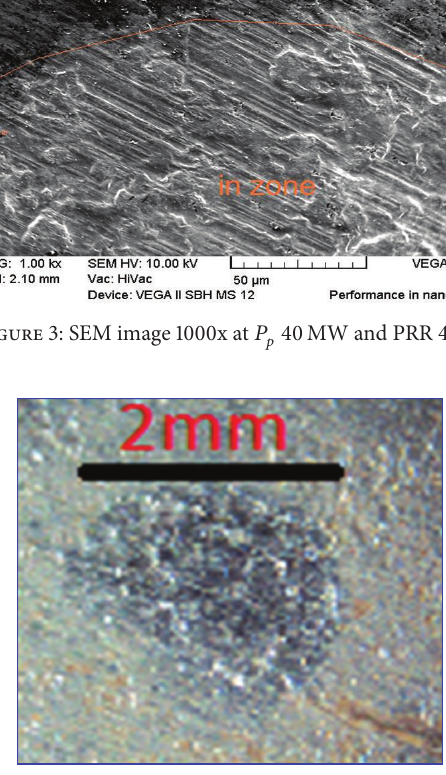
Figure 4: OM image 200x at PRR = 4 Hz; 𝑃 𝑝 = 40 M.